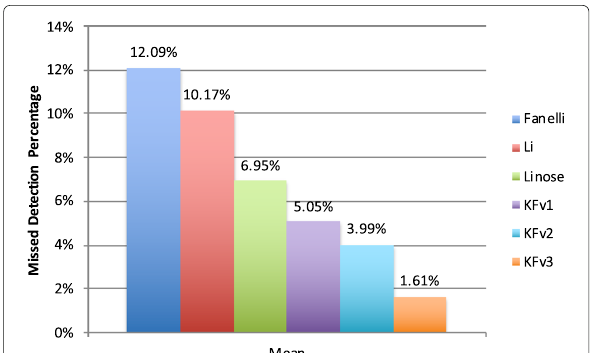
Fig. 8 Mean of the results on the BIWI dataset. Percentage of missed